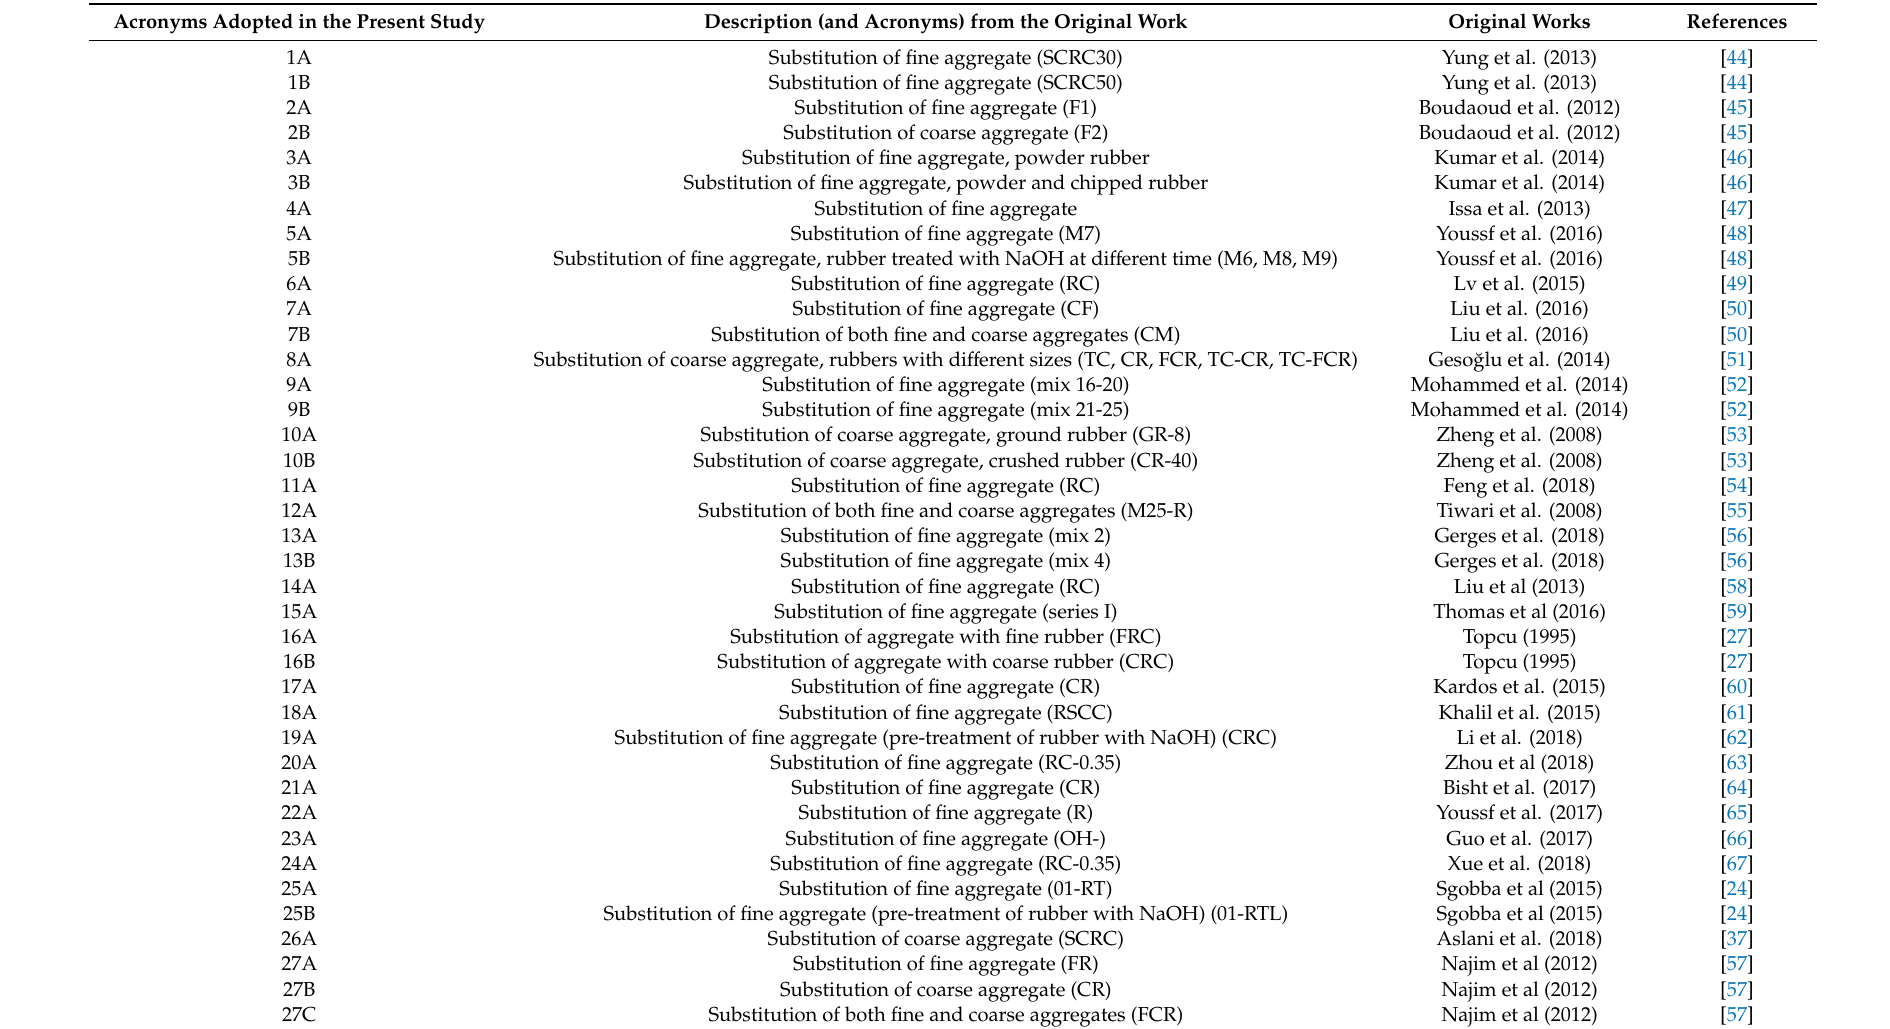
Table 1. Case studies selected for the data